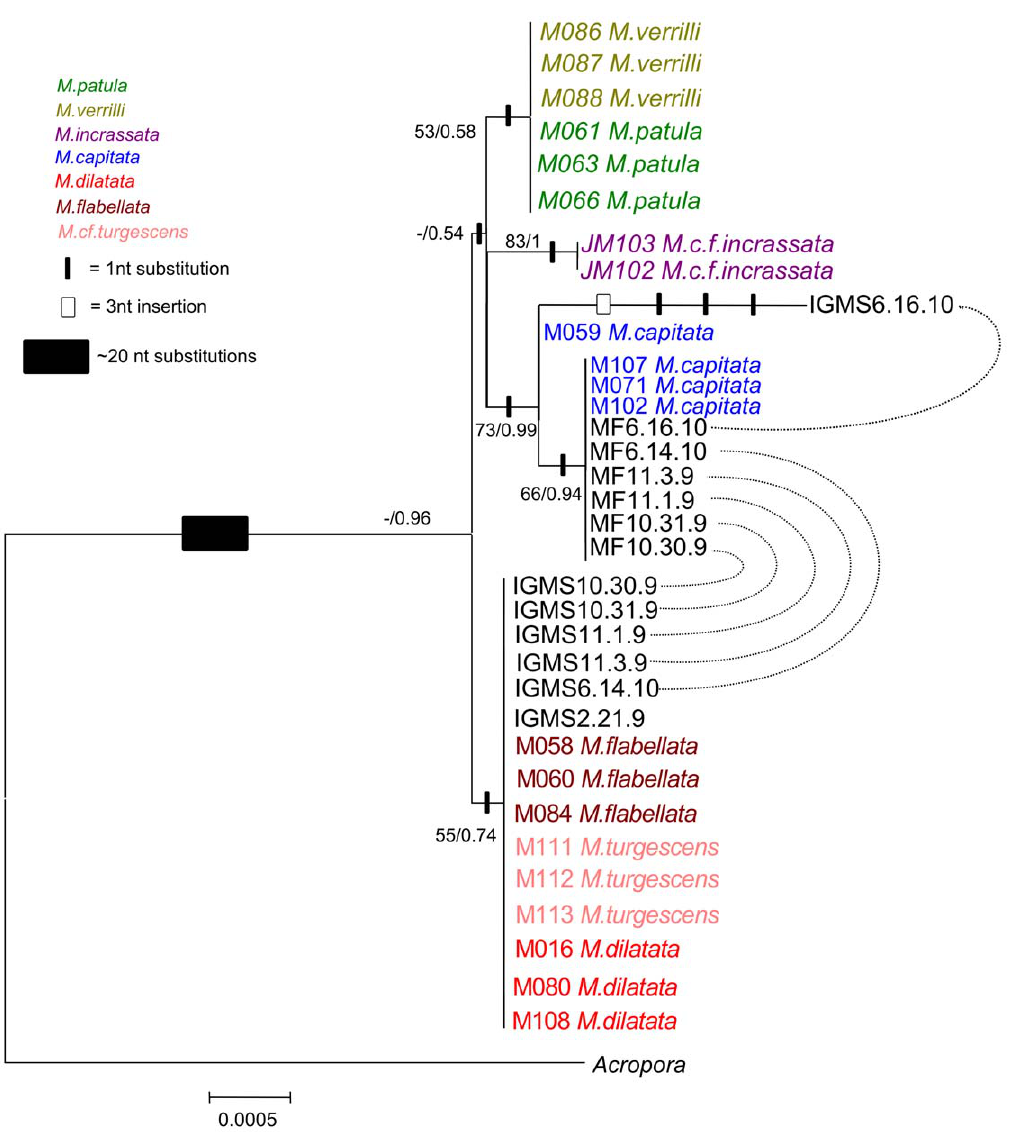
Figure 4. Bayesian inference (BI) tree of the mitochondrial CO1 sequences for Hawaiian specimens. Maximum likelihood and BI confidence values are shown. Connecting lines indicate mesenterial filaments and putative invasive gastrovascular multicellular structures (IGMS) from the same colony indicating distinct genetic types.